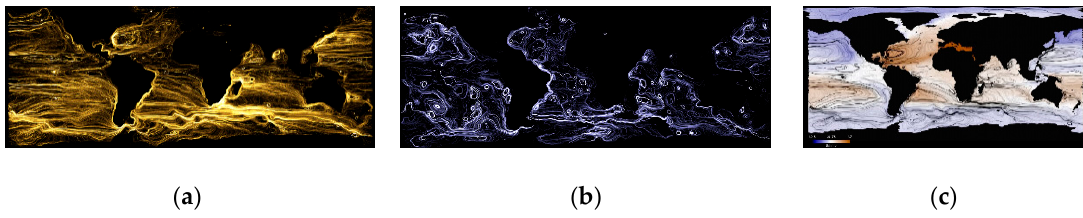
Figure 26. Additive projection of streamlines from ocean simulations: ( a ) at depths from 0 m to 500 m; ( b ) at depths from 2500 m to 3000 m; and ( c ) at 100 m with the salinity field [75].